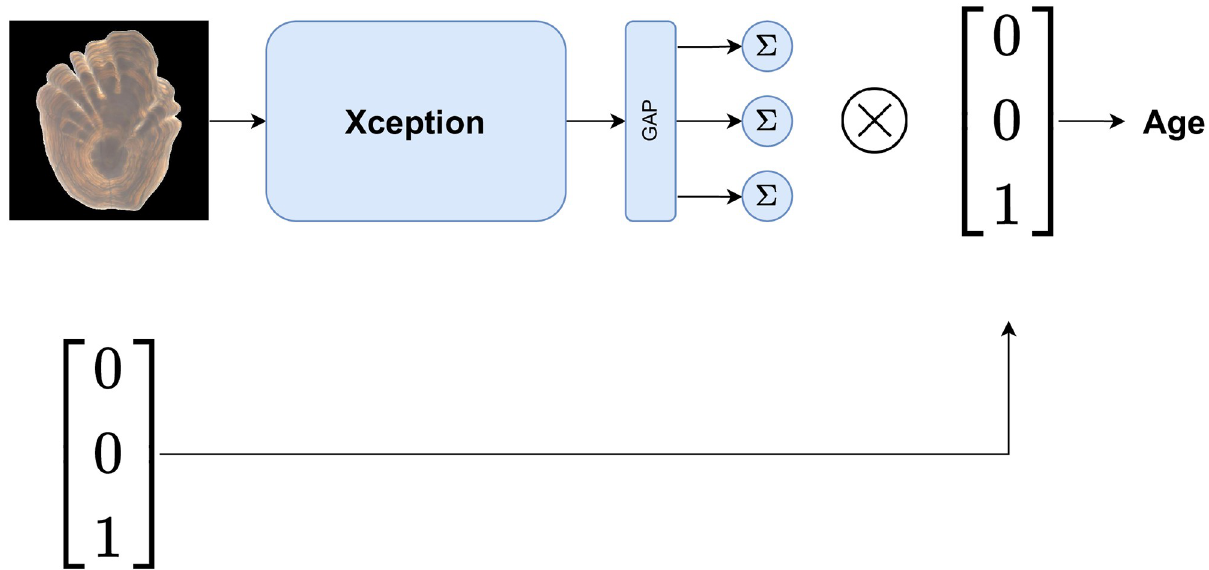
Fig 5. Model outline. Schematic look of the age estimation model. The S -nodes gives different age estimates conditioned on the sex of the input.